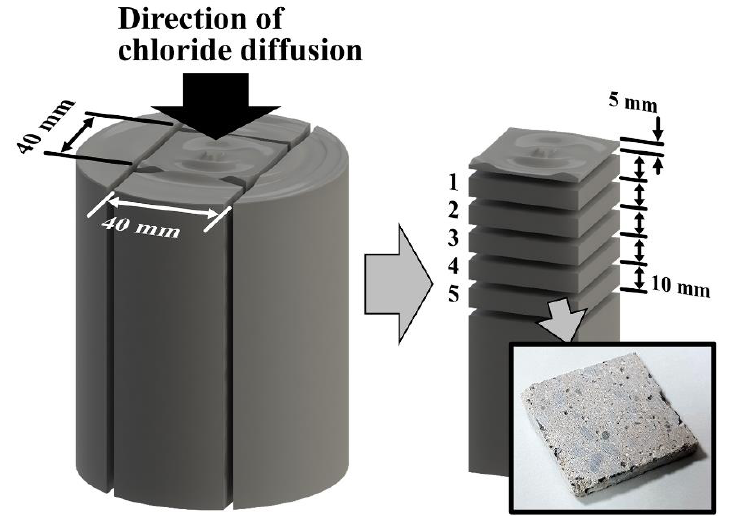
Figure 2. A sampling of the concrete cylinder samples for potentiometric titration after NaCl exposure test. (Single-column fit).